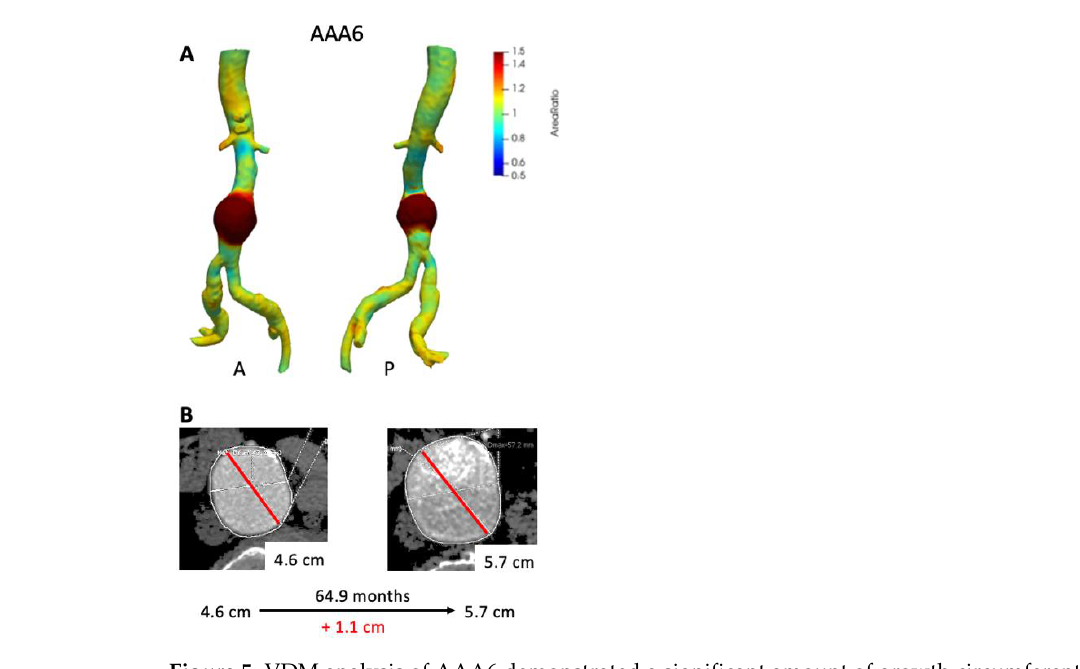
Figure 5. VDM analysis of AAA6 demonstrated a significant amount of growth circumferentially in the infrarenal abdominal aorta ( A ), and there was a corresponding increase in maximum diameter by 1.1 cm over 64.9 months ( B) . A = anterior projection, P = posterior projection.